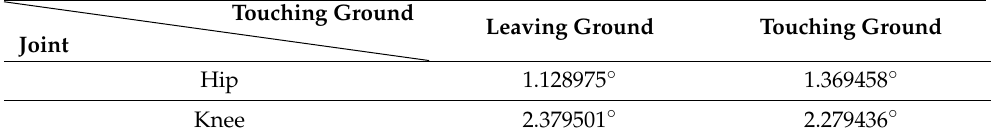
Table 3. RMSEs of joint trajectories for different triggering